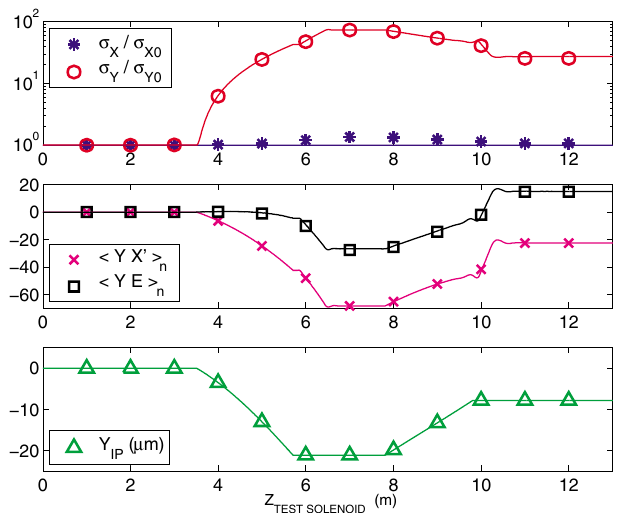
FIG. 10. (Color) Beam size, major correlations, and Y position at the IP for the short test solenoid placed on the detector axis at distance z from IP. Symbols: tracking; solid line: analytic solu- tions. IP is at z (cid:3) 0 m